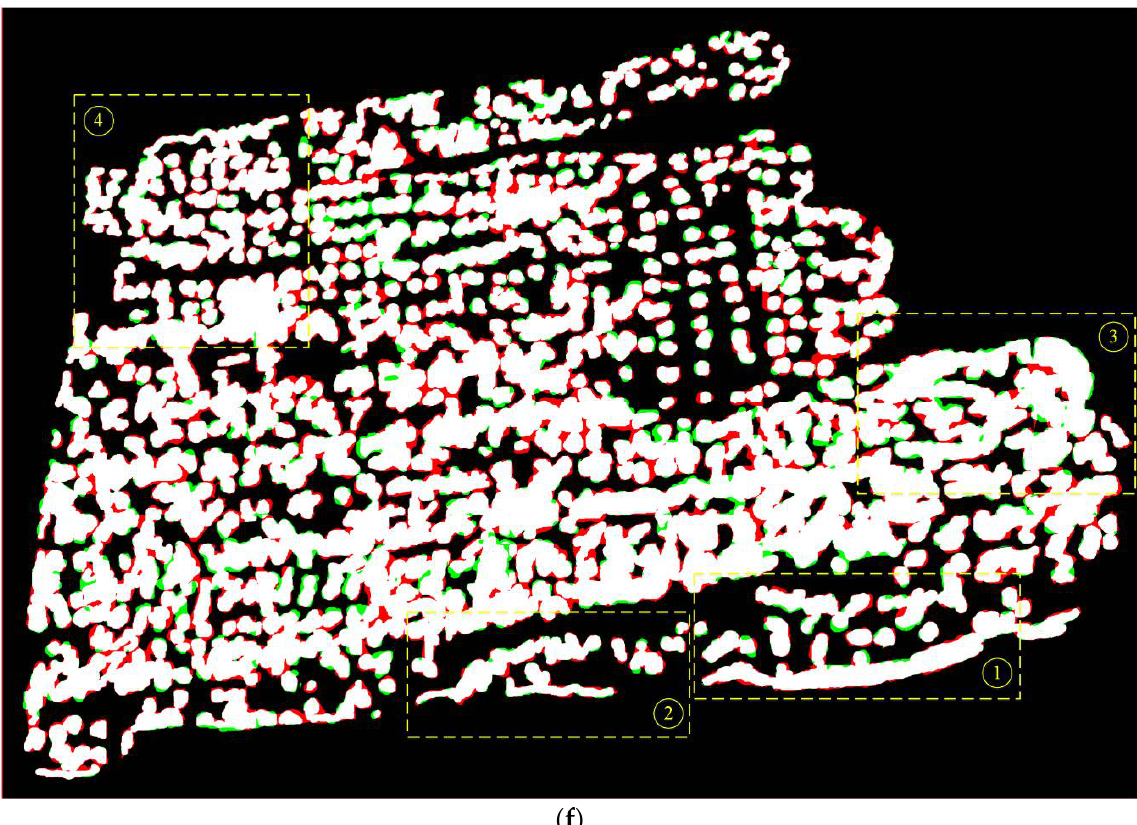
Figure 6. ( a , d ) are the large-scale multibeam sonar images. ( b , e ) are the artificial reef detection results using SegNet. ( c , f ) are the artificial reef detection results using AR-Net. The yellow rectangles with the numbers represent the key comparison areas of the algorithm results.